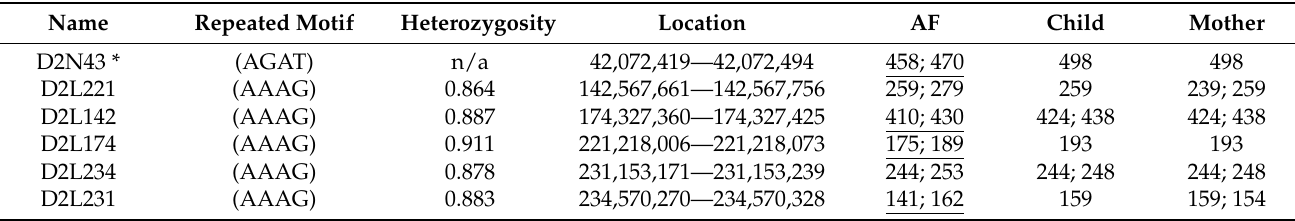
Table 1. Characteristics of selected STR type markers located on chromosome 2 together with the results of their examination for the alleged father, child, and mother. The chromosome location, repeat motif, heterozygosity (based on strcat.teamerlich. org), and arbitrary size in bp are indicated. Underlined genotypes show a lack of inheritance of common alleles between the alleged father (AF) and